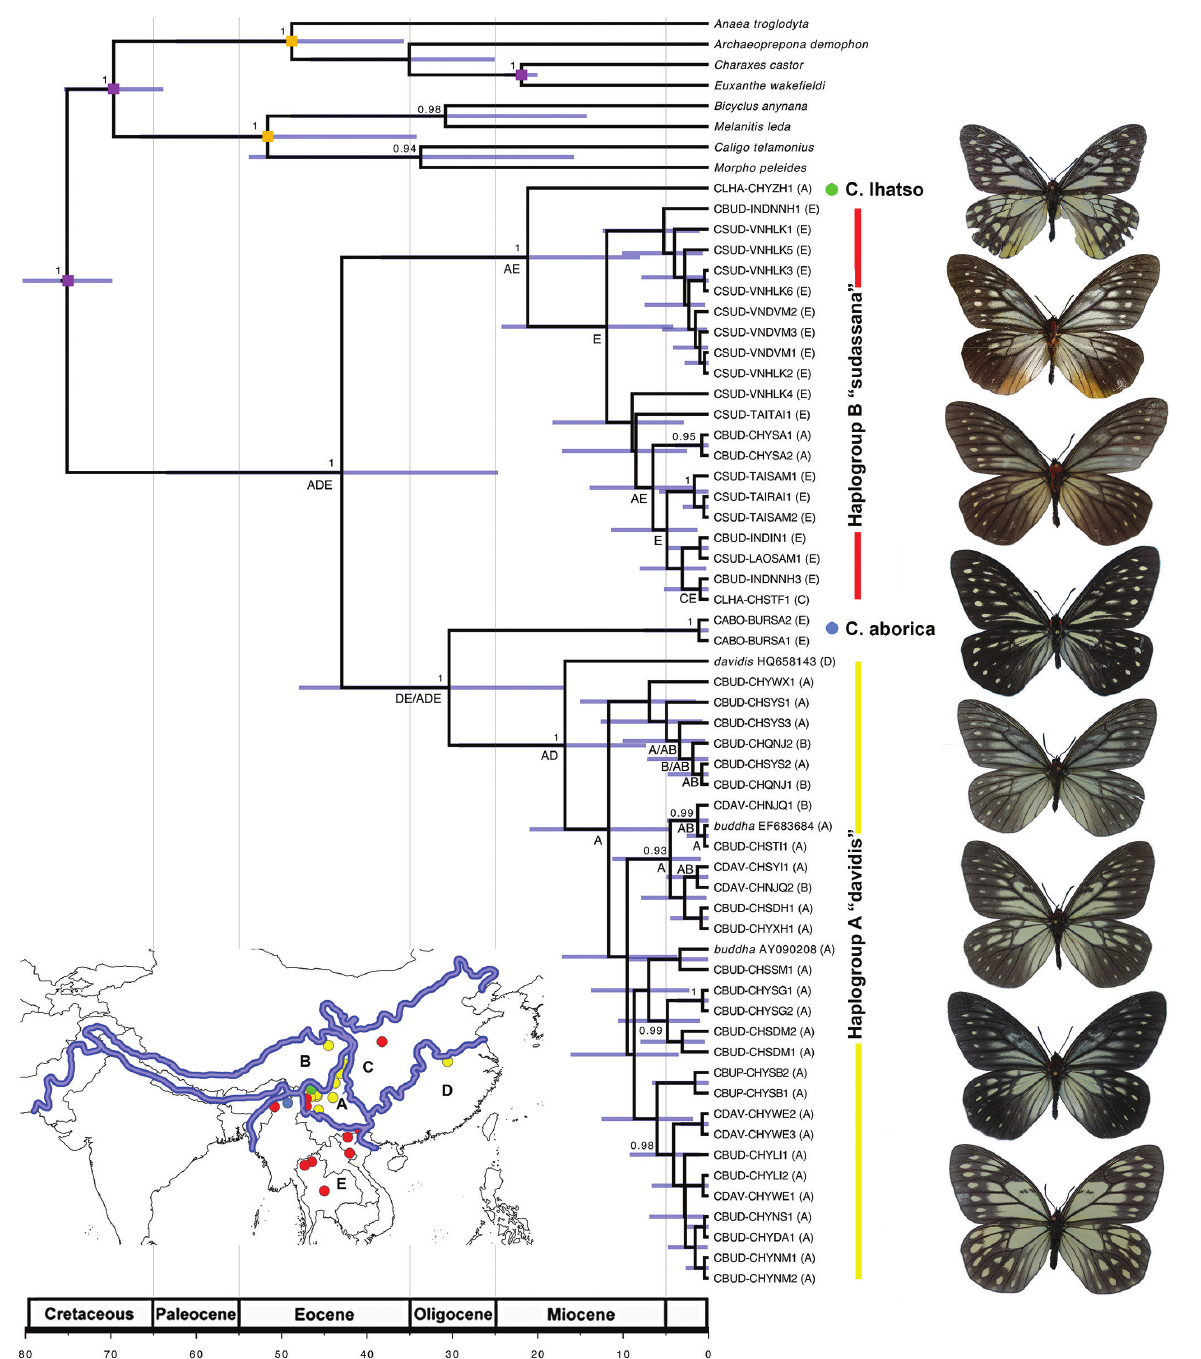
Figure 2. Bayesian phylogeny of Calinaga estimated in BEAST using concatenated data. Purple squares are calibration points (root: 75 ± 3; Satyrinae + Charaxinae 70 ± 3.5, Charaxes + Euxanthe 22 ± 1). Monophyly was enforced on nodes marked with orange squares. The inset map shows the biogeographic regions used in DIVA analysis: A) Southwestern China ecozone, B) Himalaya-Tibetan plateau region, C) Northern Sino-Himalaya, D) Southern Sino-Himalaya, E) Indochina. Colored dots correspond to haplogroups on the